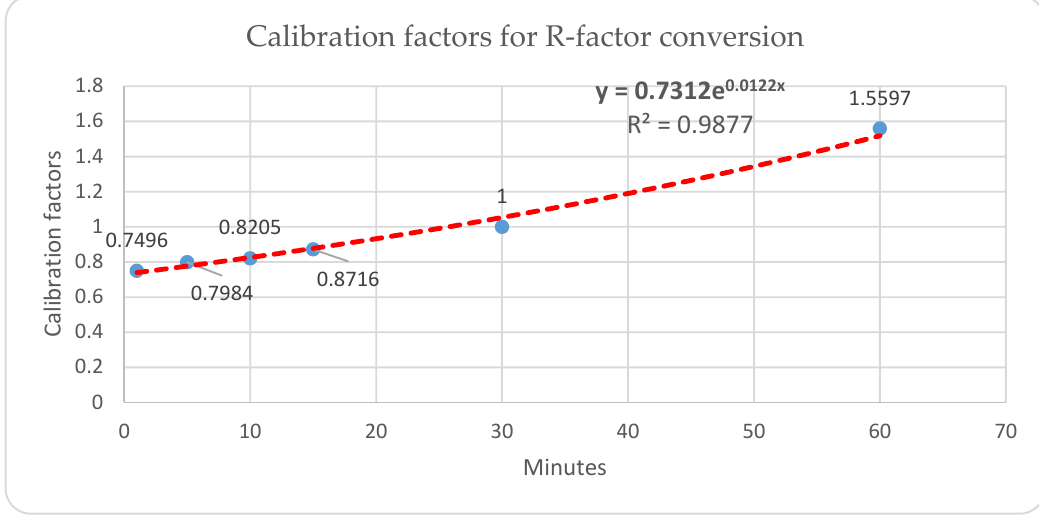
Figure 2. Suggested regression curve for R-factor values at different time resolutions in Europe with the 30-min resolution data set as a reference value.